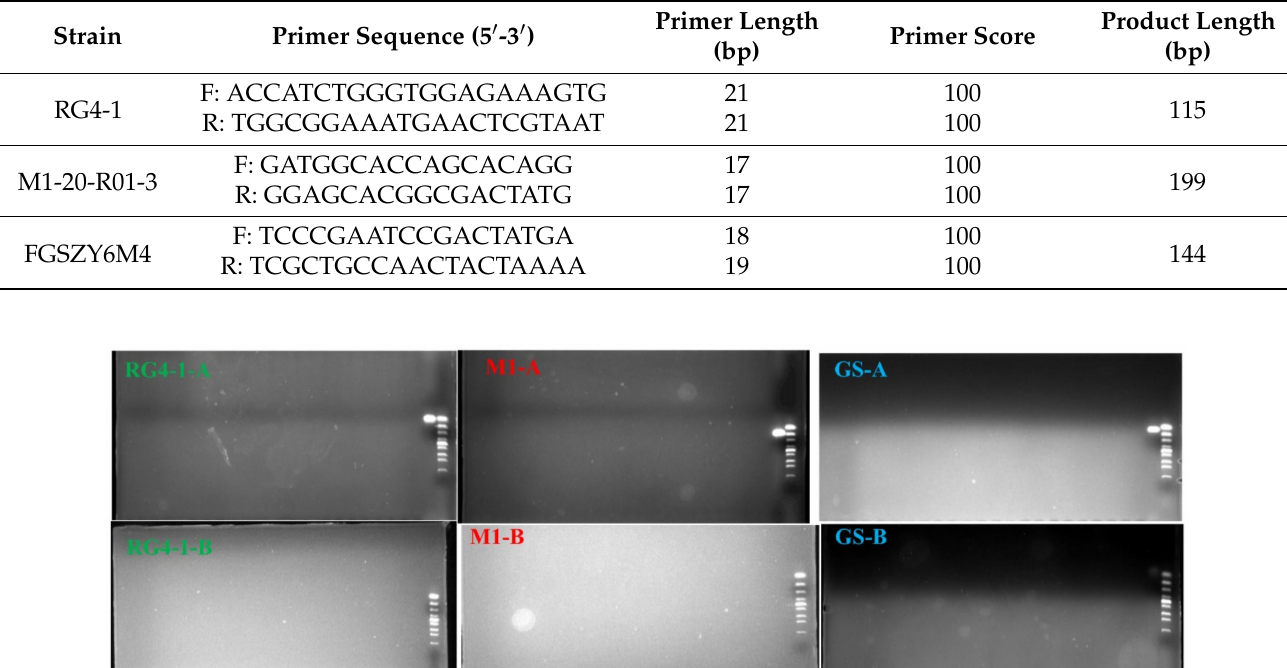
Figure 3. Electrophoresis results of PCR products generated using each strain-specific qPCR primer pair against DNA from the respective target B. longum strains and non-target microorganisms. Each gel includes 25 lanes (including a lane for the gene ruler). Order of microorganisms were as follows: for RG4-1-A (from right to left), gene ruler, B. longum